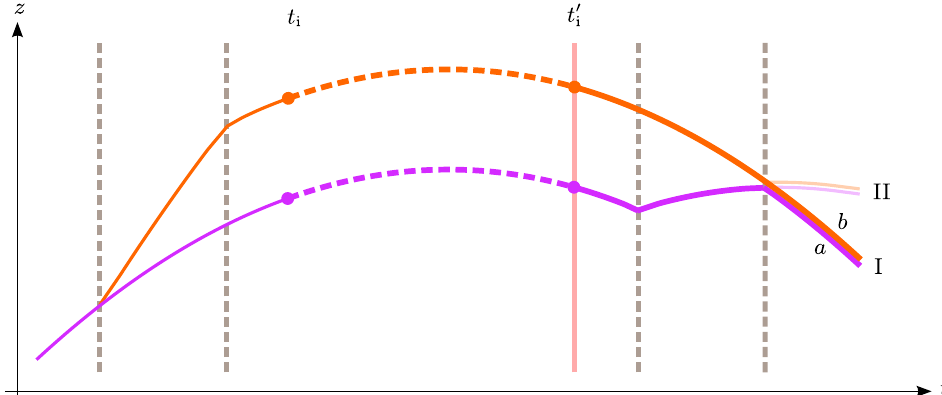
FIG. 1. Central trajectories for a reversed Ramsey-Bord´e interferometer in a uniform gravitational field. A doubly differential measurement comparing the outcomes for different initialization times ( t the two dashed worldline segments and is sensitive to gravitational time-dilation